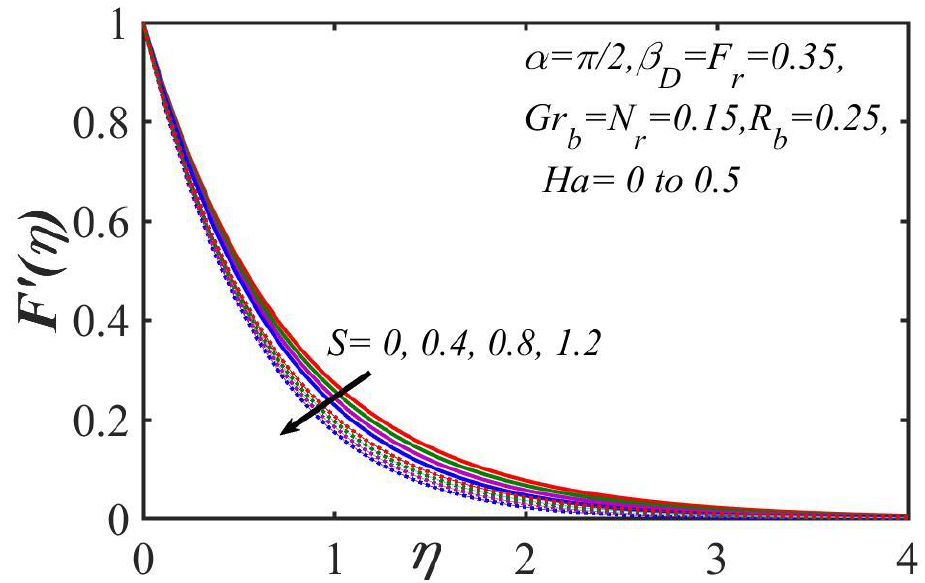
Figure 2. Variation of 𝑆 and 𝐻𝑎 over velocity magnitudes. Solid curve: 𝐻𝑎 = 0 ; dotted curve: 𝐻𝑎 = 0.5 .